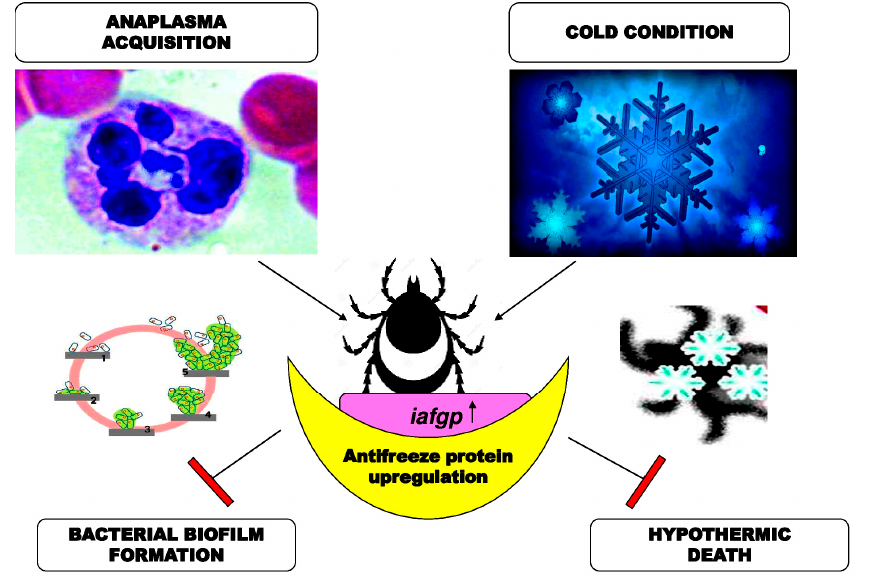
Figure 5. Functions of Ixodes scapularis antifreeze glycoprotein (IAFGP) as an anti-virulence element against various microbes, such as the methicillin-resistant Staphylococcus aureus (MRSA)